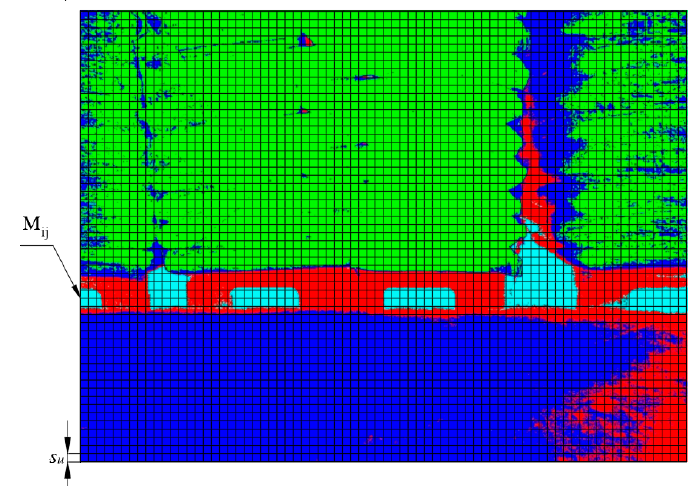
Figure 4. Category matrix example. Element labels are represented with different colors. Green represents goods. Red represents pallets. Blue represents ground. Light blue represents pallet holes. s u and M ij represent the grid compressing unit size and the grid unit vector of category matrix, respectively (explained in Section 2.5 below).